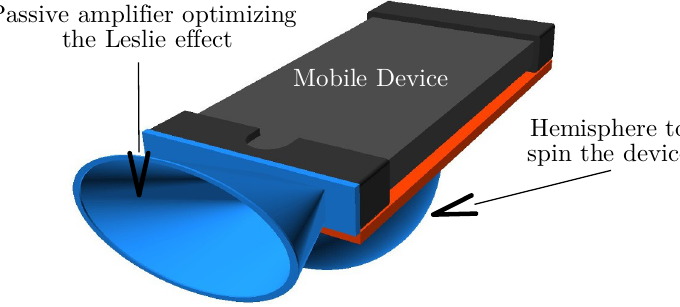
Figure 7. Mobile-device-based top creating a “Leslie” effect when